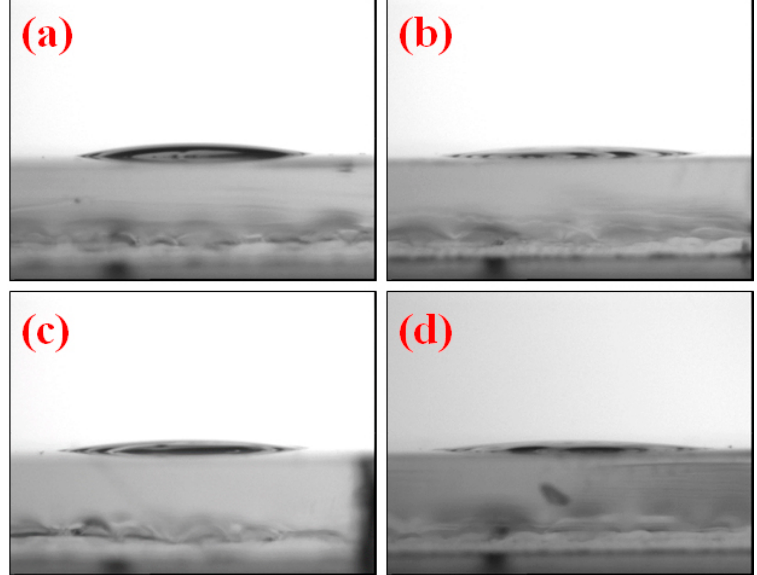
Figure 2. Water contact angle (WCA) as a function of the UV light wavelength (A, B, or C); ( a ) without UV light treatment, ( b ) 254 nm, ( c ) 302 nm, and ( d ) 365 nm.